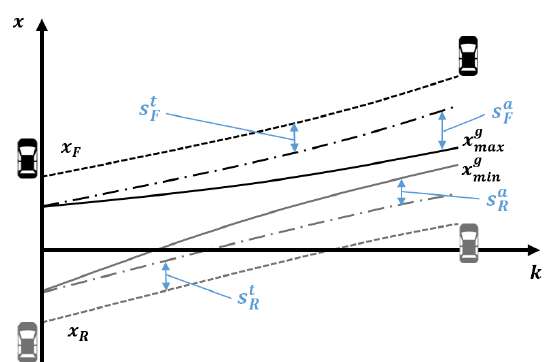
Figure 5. Illustration of the constraint sequence for current or target vehicle gap. The black car symbol represents the leading vehicle, whose tail position with respect to time is described by curve x F . The difference x F − x g max can be divided into two parts: s t and s a , which starts from 0 and increases over time. A similar process is applied to the following F vehicle, which is colored in